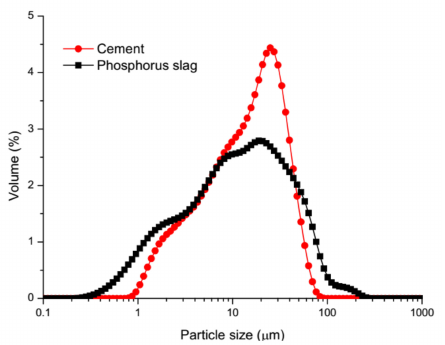
Figure 1. Particle size distributions of cement and phosphorus